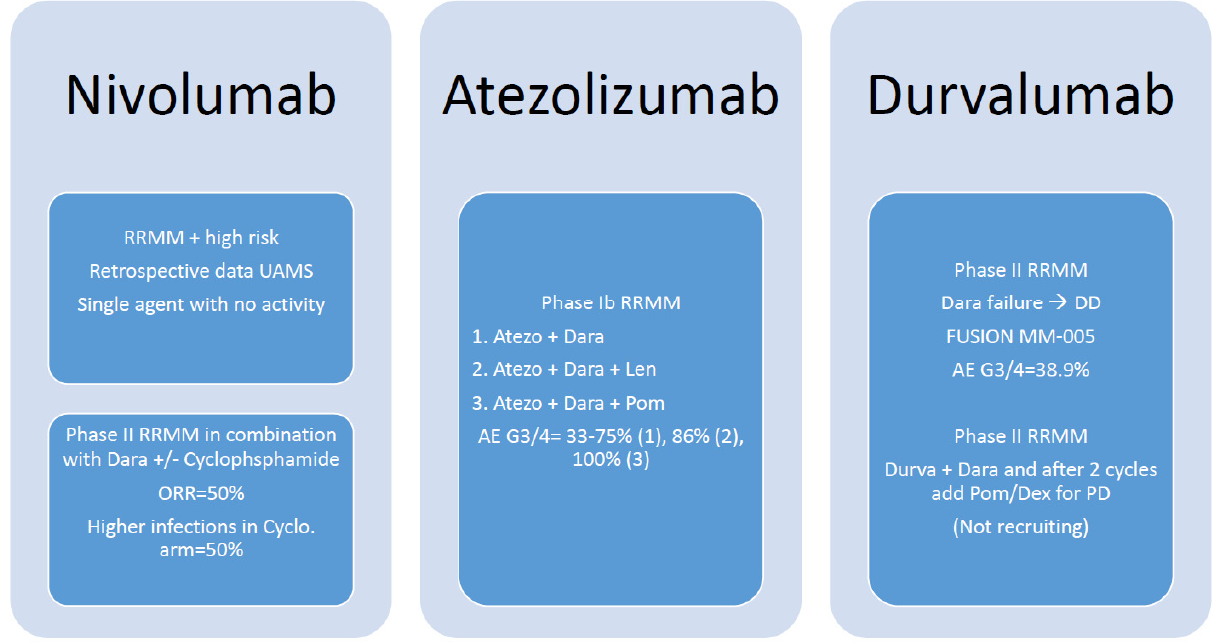
Figure 2. Summary of clinical trials for nivolumab, atezolizumab, and durvalumab in multiple my- eloma.